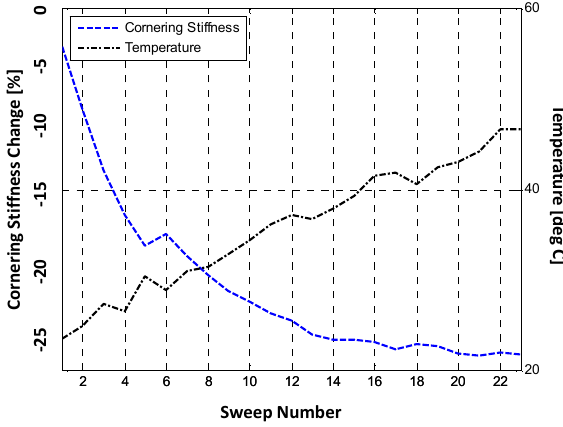
Figure 15. Influence of temperature on the tire cornering stiffness.